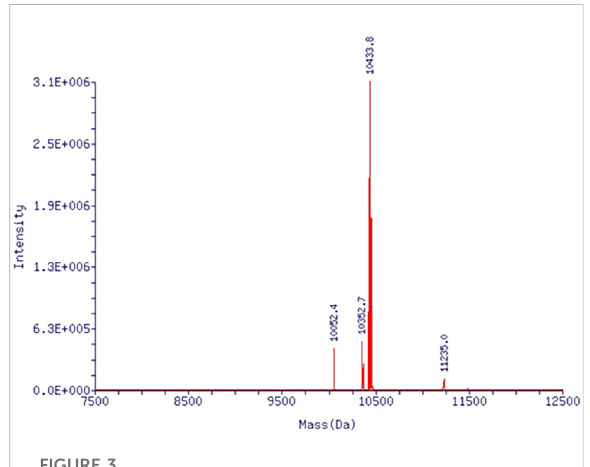
FIGURE 3 Mass spectrum of ON-CAG conjugates. Mass spectrum showed an exact molecular weight of